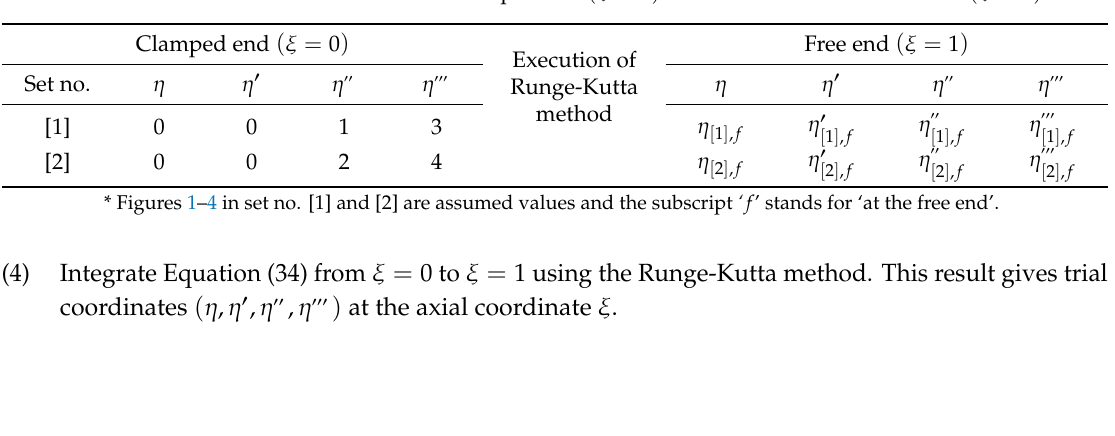
Execution of Runge-Kutta method